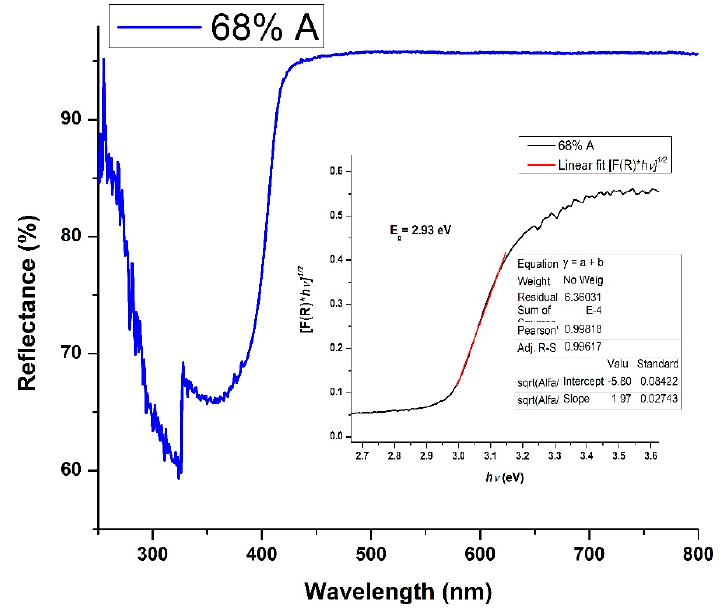
Figure 5. Diffuse reflectance spectrum for a sample containing 68% of anatase.